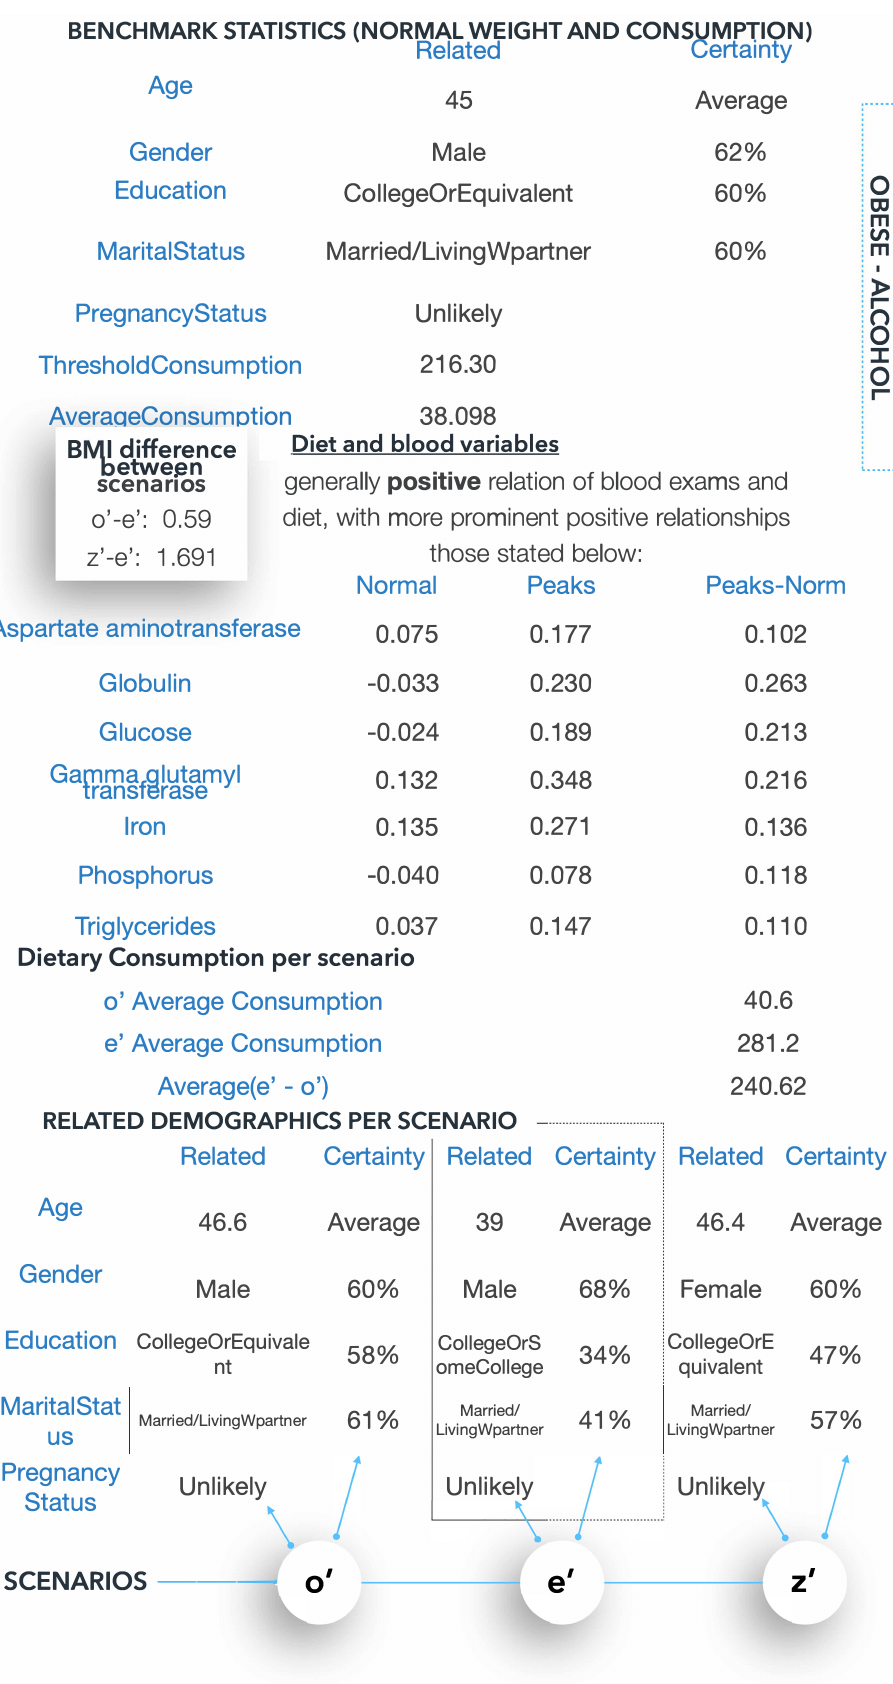
Figure 13. Alcohol, related demographics and